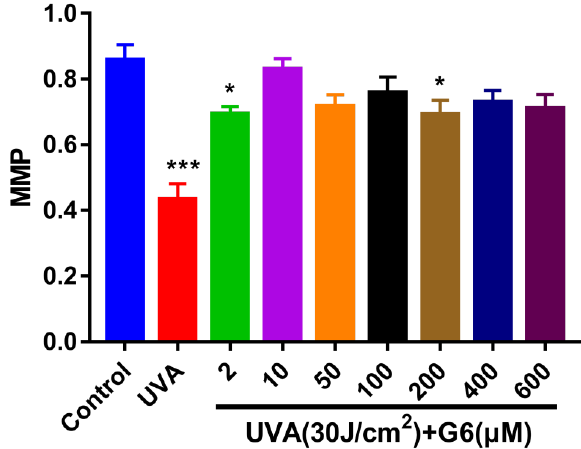
Figure 3. HaCaT Cells were incubated with specific concentrations of G6 for 48 h and then irradiated with UVA (30 J / cm 2 ). Significant di ff erence from control group: * p < 0.05 and *** p < 0.001, bars and error bars are expressed as mean ± S.E.M ( n =